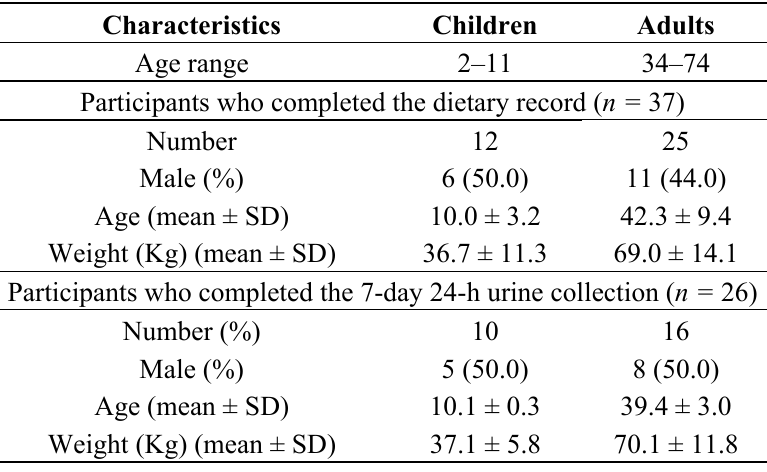
Table 1. Characteristics of child and adult participants.